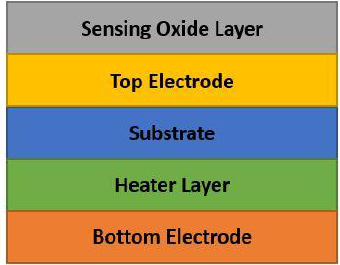
Figure 13. Device structure for V/SnO 2 CO gas sensor.